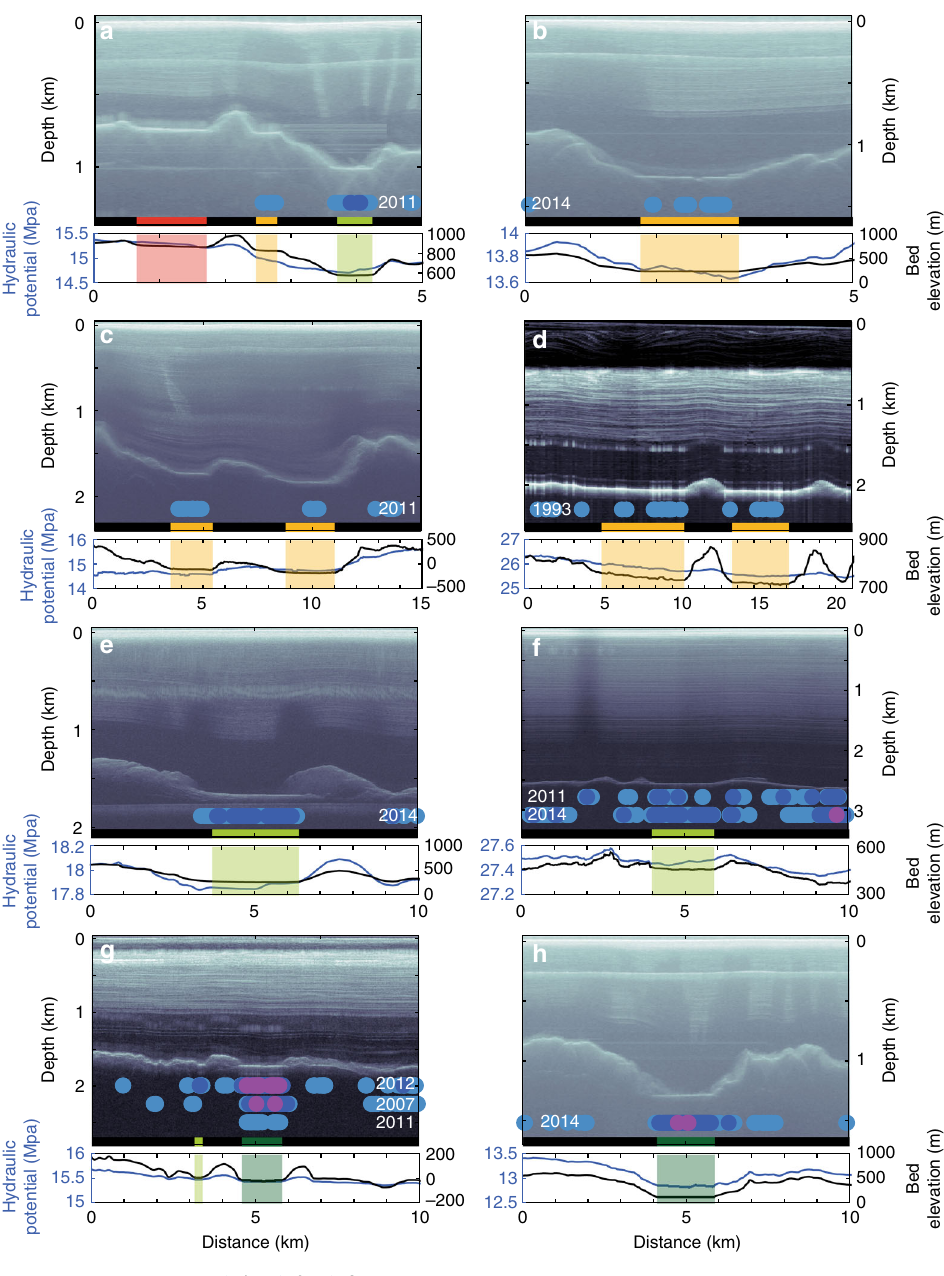
Reflectivity thresholds: Confidence levels:1 σ Fig. 1 Example RES pro fi les for 13 subglacial lakes identi fi ed beneath the Greenland Ice Sheet in this study and the surrounding bed topography. Relative basal re fl ectivity values (1 – 3 σ ) are indicated by the blue-purple circles. Lakes are depicted by a bar colour-coded according to the con fi dence level (see Fig. 3). The bedrock elevation (black) and hydraulic potential (blue) are shown in the graphs below. a Lakes 32 – 34 along fl ight line 20120516_01_059, b lake 39 along fl ight line 20120503_03_037, c lakes 24 – 25 along fl ight line 20110329_01_019, d lakes 56 – 57 along fl ight line 19930702_01_012, e lake 29 along fl ight line 20140313_08_001, f lake 45 along fl ight line 20140424_01_033, with re fl ectivity values for years 2011 and 2014, g lakes 18 – 19 along fl ight line 20020530_01_007, with re fl ectivity values for years 2002, 2007 and 2011, h lakes 30 – 31 along fl ight line 20140313_08_002